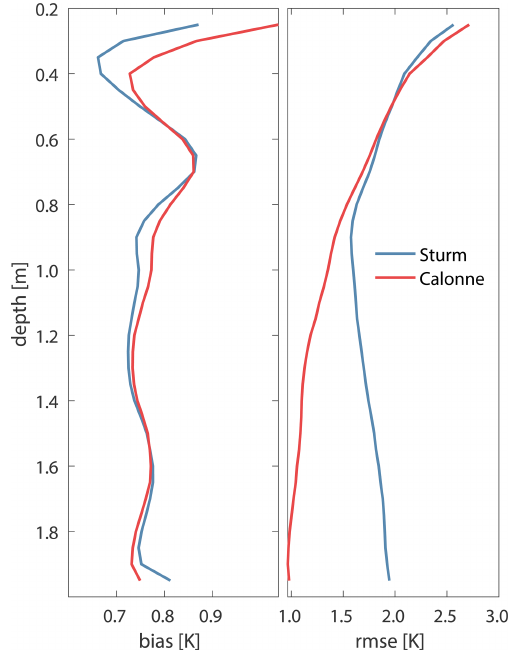
Figure 13. Mean bias (left) and RMSE (right) in modeled near- surface temperatures as a function of depth relative to observations (Miller et al., 2017). Daily GEMB model results using Sturm et al. (1997) and Calonne et al. (2011) thermal conductivity parameter- izations for Summit Station, Greenland (72.580 ◦ N and 38.459 ◦ W), from July 2013 to June